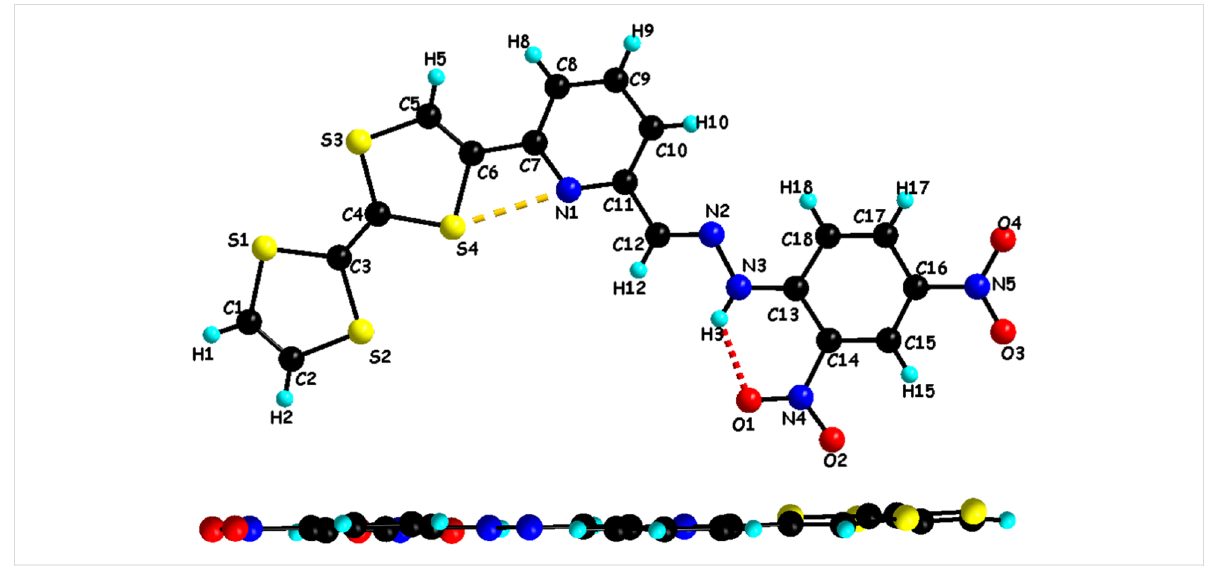
Figure 1: Crystal structure of ligand L1 with atom numbering scheme (top) and a side view of the molecule (bottom).